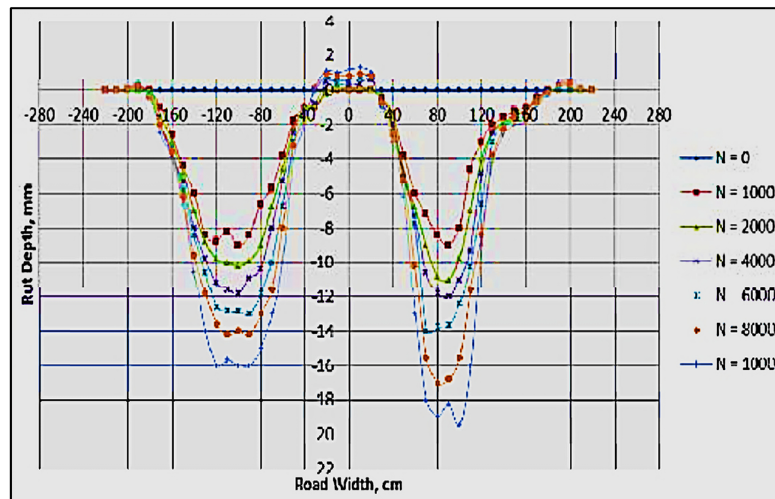
Figure 15: Rutting depth at interfaces I + II.